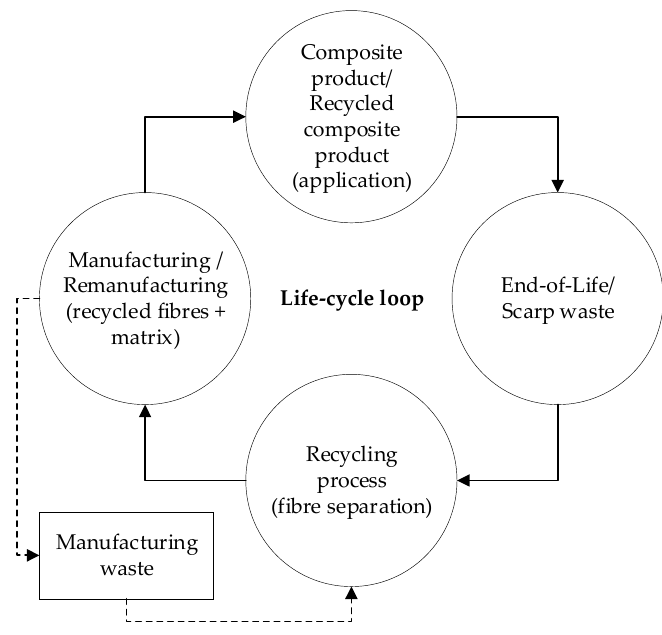
Figure 1. Life-cycle loop of carbon fibre-reinforced polymer (CFRP) and glass fibre-reinforced polymer (GFRP).